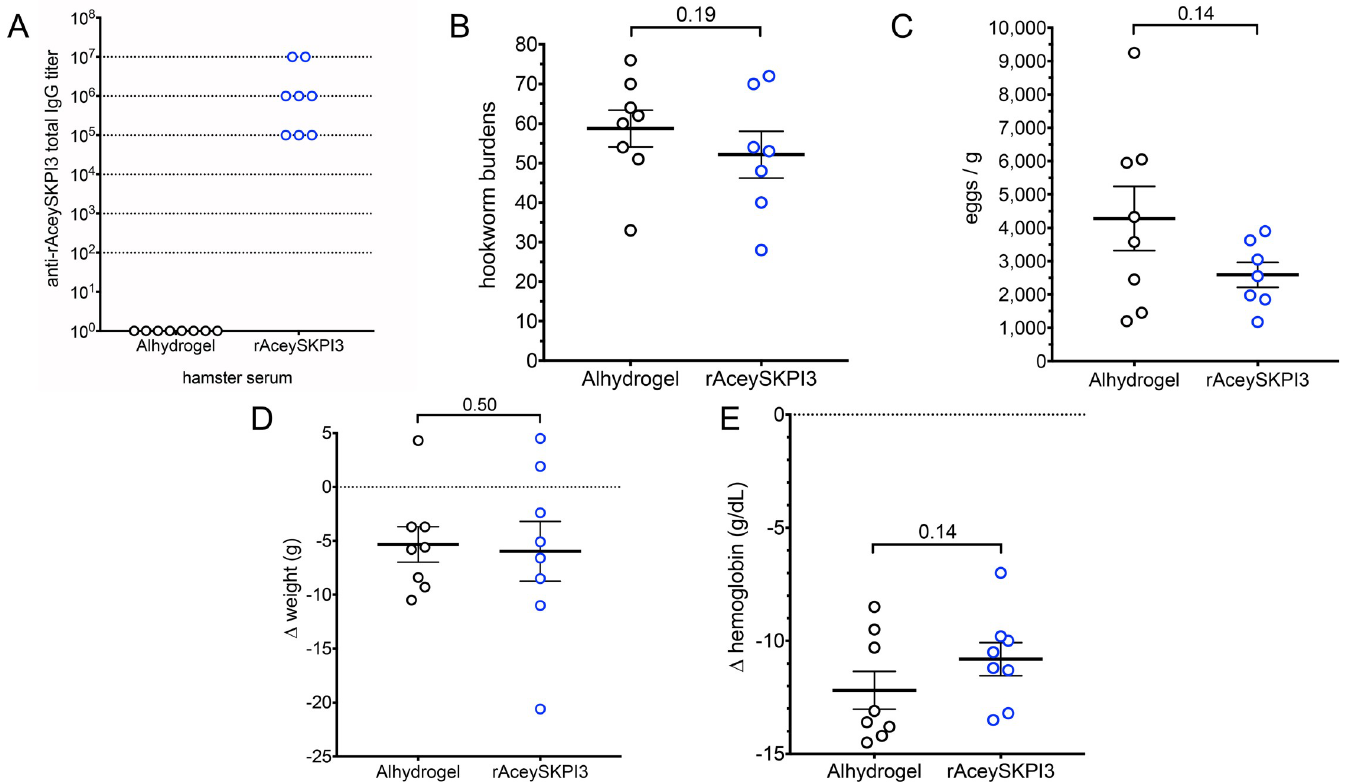
Fig 4. rAceySKPI3/Alhydrogel vaccine trial. (A) rAceySKPI3 serum IgG titers in Alhydrogel controls and rAceySKPI3/Alhydrogel vaccinates. Dotted lines indicate the inverse of serum dilutions tested. (B) Comparison of mean hookworm burden between rAceySKPI3/Alhydrogel and Alhydrogel control vaccinates. (C) Comparison of mean FEC between rAceySKPI3/Alhydrogel and Alhydrogel control vaccinates. (D) Comparison of mean change in weight after hookworm infection between rAceySKPI3/Alhydrogel and Alhydrogel control vaccinates. (E) Comparison of mean change in hemoglobin concentration after hookworm infection between rAceySKPI3/Alhydrogel and Alhydrogel control vaccinates. (B, C) For rAceySKPI3/Alhydrogel, n = 7 as 1 vaccinate died on day 21 PI ( i . e ., one day after obtaining Δ weight (D) and Δ hemoglobin (E); hookworm burden and FEC were determined on day 23 PI).